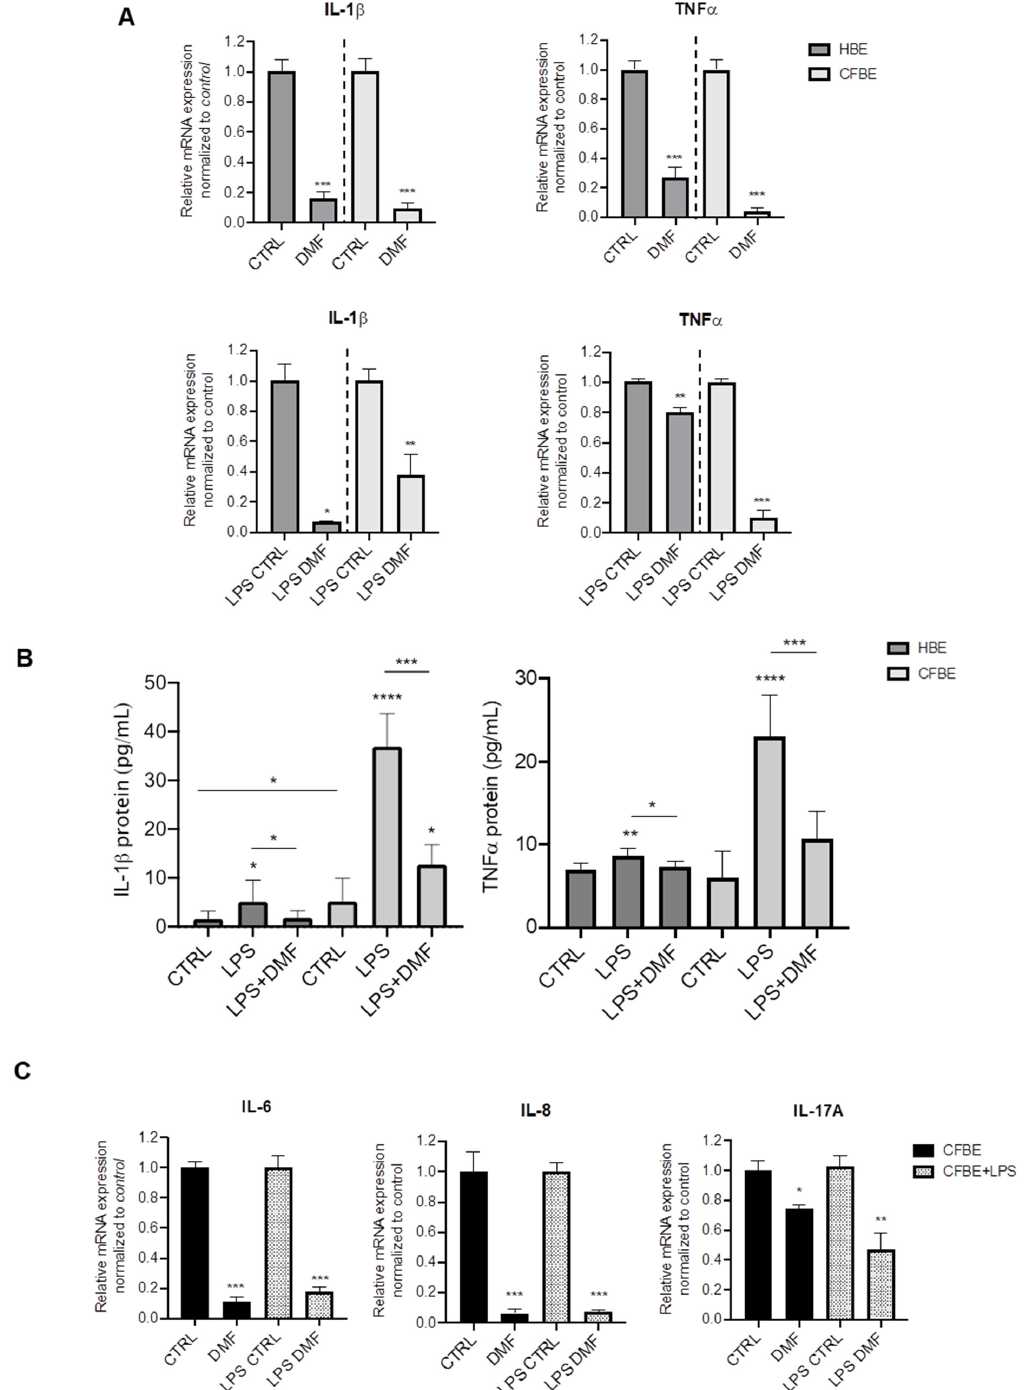
Figure 1. Co-treatment with DMF reduces the expression of IL-1 β and TNF- α stimulated by LPS in HBE and CFBE cells. ( A ) Cells were incubated with 0.1% DMSO (CTRL) or 50 µ M DMF +/ − 10 µ g/mL of LPS for 4 h. Total RNA was extracted and qRT-PCR was performed in order to quantify IL-1 β and TNF- α mRNA normalized to untreated control. Data represent the mean ± SD ( n = 4). ( B ) IL-1 β and TNF- α secretion after stimulation with 0.1% DMSO (CTRL) or 50 µ M DMF +/ − 10 µ g/mL of LPS for 24 h. Data represent the mean ± SD ( n = 6–8). ( C ) Cells were incubated with 0.1% DMSO or 50 µ M DMF +/ − 10 µ g/mL of LPS for 4 h. Total RNA was extracted and qRT-PCR was performed in order to quantify IL-6, IL-8 and IL-17A mRNA normalized to untreated control. In ( A ) and ( C ), results are shown as fold induction where CTRL is equal to 1. Data represent the mean ± SD ( n = 4). * p < 0.05; ** p < 0.01; *** p < 0.001; **** p <